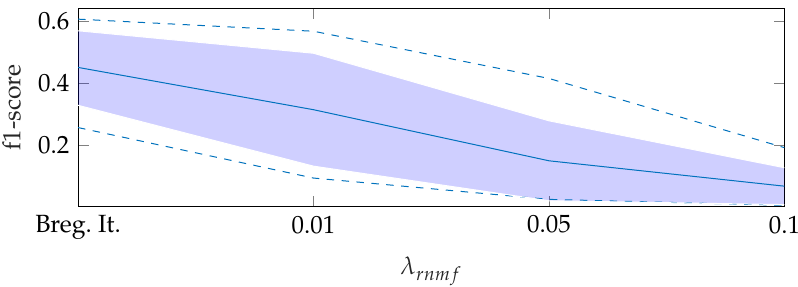
Figure 7. F1-score for automatic segmentation depending on λ rnmf , where the dashed lines show the minimum and maximum f1-score values, and the standard deviation is indicated by the filled